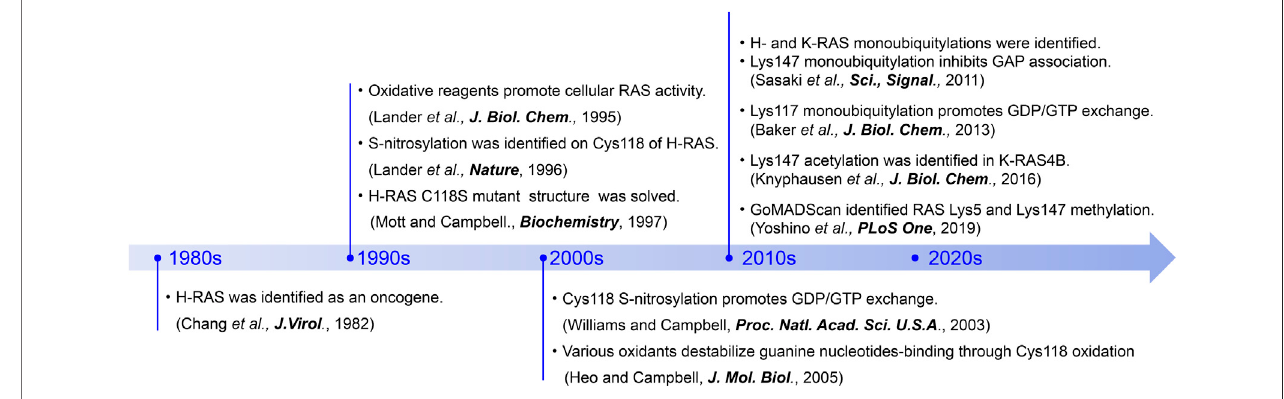
FIGURE 3 | A chronicle of RAS-related discoveries highlighted in this